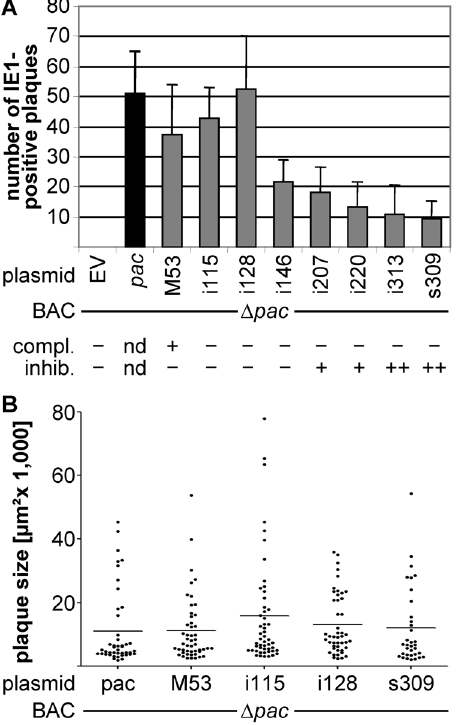
Figure 4. Complementation of the pac deletion and validation of the cell-based inhibitory screen. (A) Flpe-NIH were nucleofected with the D pac BAC and either an empty control shuttle vector (EV), a rescue plasmid carrying the pac sequences ( pac , black bar), or a rescue plasmid carrying the pac plus different M53 mutants, mixed with NIH/ 3T3 and fixed at 6 dpt. Cells were fixed with an IE1-specific antibody and the number of IE1-positive plaques was quantified. Depicted are mean and SD of triplicate values of three independent experiments. M53 mutants were derived from a transposon-based random muta- genesis described and characterized in [17,33]. Their capacity to complement the wt pM53 function of a D M53 virus (compl.) and to inhibit the wt pM53 function in a dominant negative manner (inhib.) is indicated below the diagram. (B) Flpe-NIH were treated as described in (A). Images of IE1-positive foci were taken and the size of the